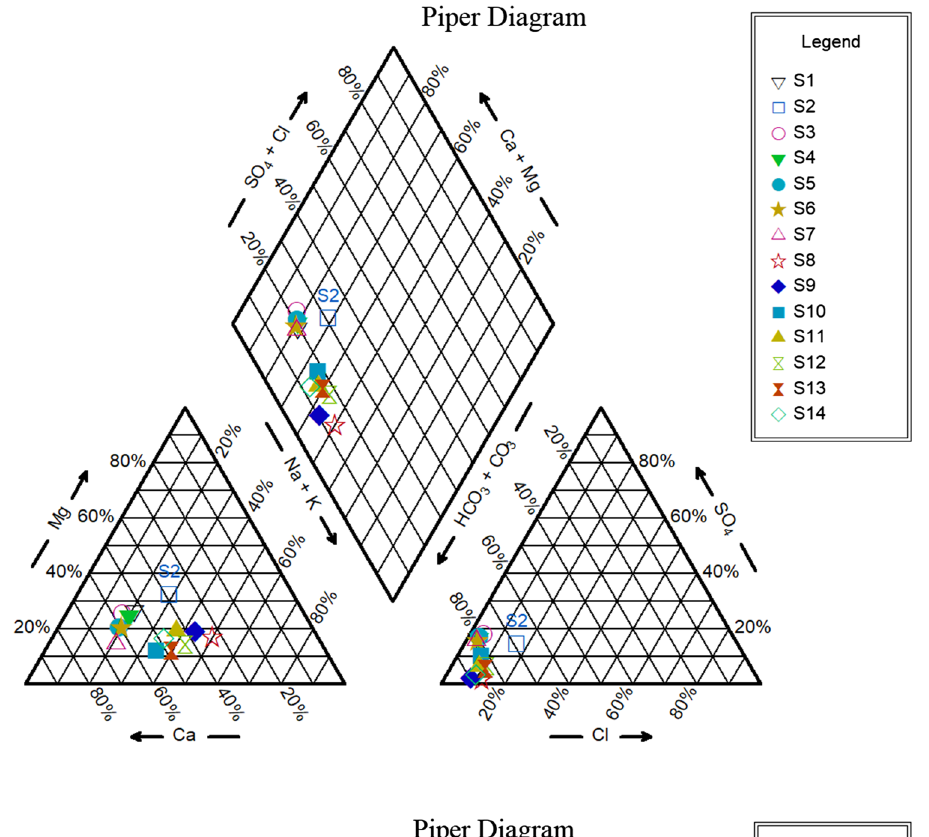
Fig. 3 Piper diagram of post- monsoon season